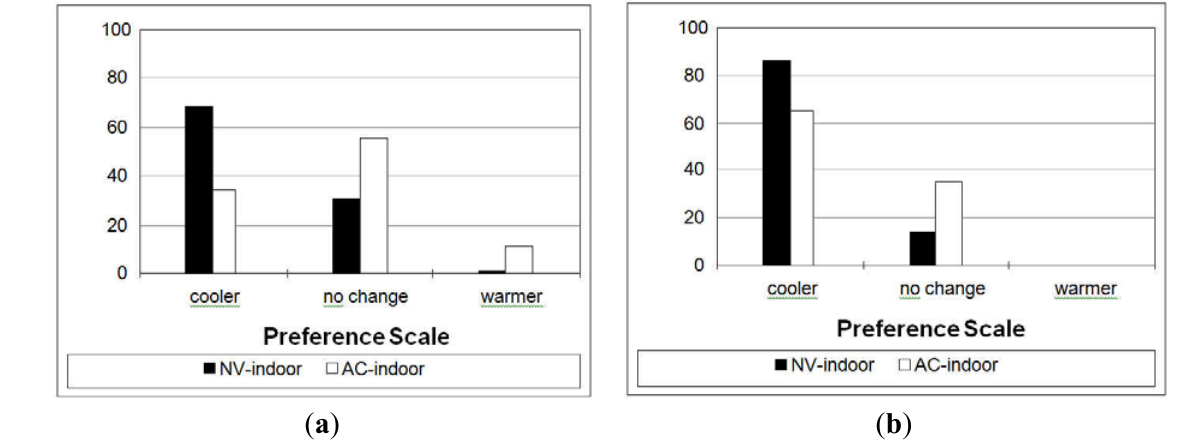
Figure 3. Relative frequency distribution (%) of thermal preference votes in ( a ) the cool season; and ( b ) the warm season (NV = naturally ventilated; AC =